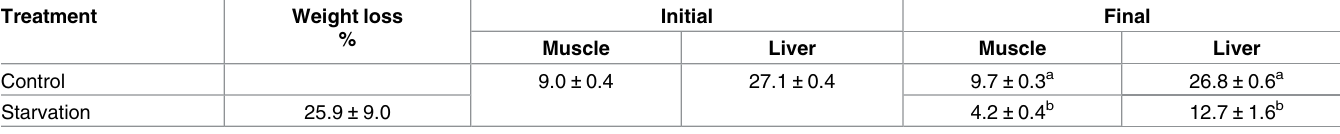
Table 2. Total weight loss and crude fat content from muscle and liver tissues of S . lalandi before and after 35 days under starvation (n = 3) com- pared to the fed group (control). Initial samples were pool together (n = 6). Treatment